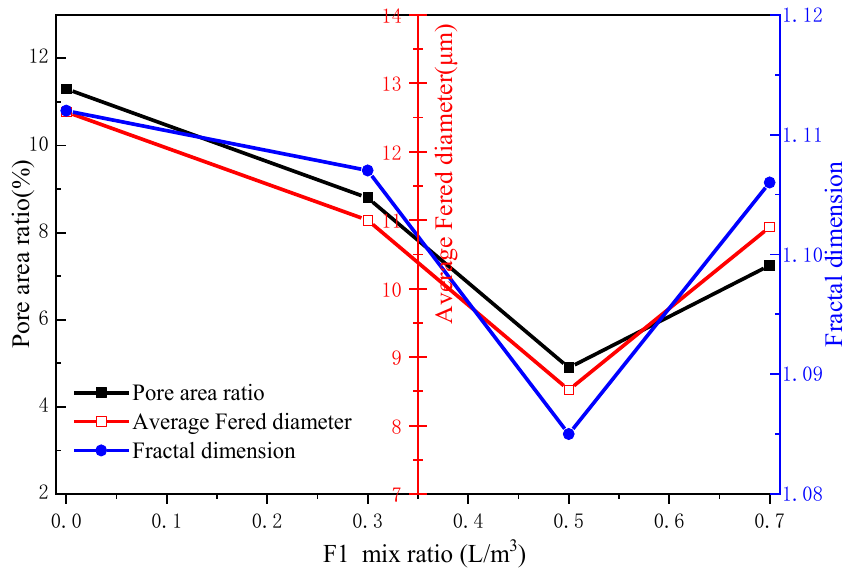
Figure 10. Relationship curve between micropore structure parameters of red clay and F1 content. The pore area ratio, average Feret diameter, and fractal dimension of red clay exhibited a change regulation of first decreasing and then increasing with increased F1 content. The 0.5 L/m 3 F1 sample had a 56.64% lower pore area ratio, 32.37% lower average Feret diameter, and 2.43% lower fractal dimension compared to the virgin red clay, indicating that the pore size and area of F1 reinforced red clay were significantly reduced and that the pore morphology tended to be regular from the complex connected band structure.